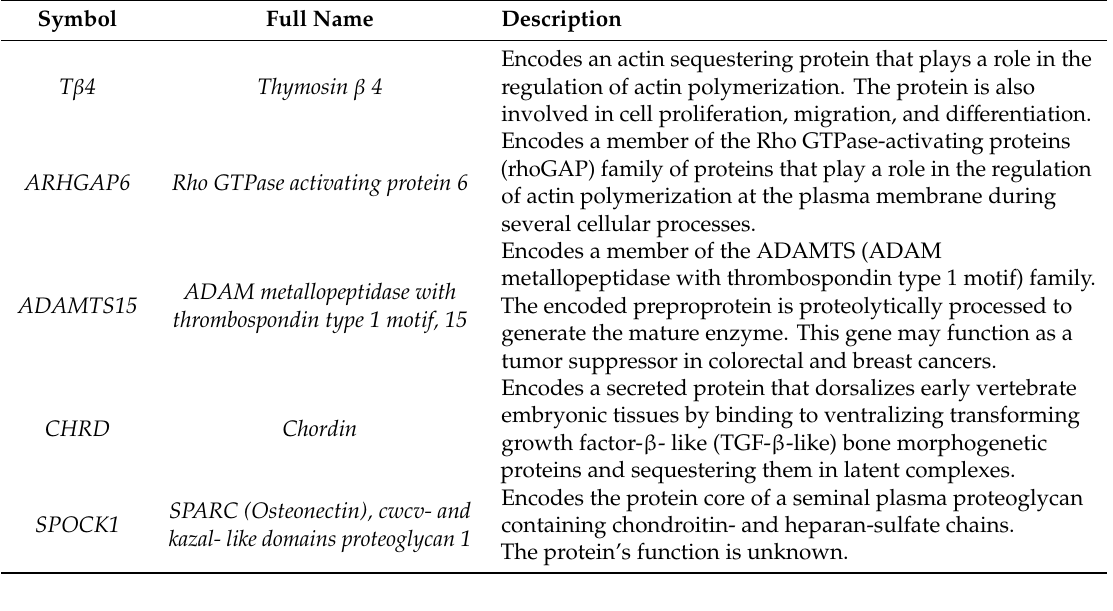
Table 1. Summaries for five candidate genes.